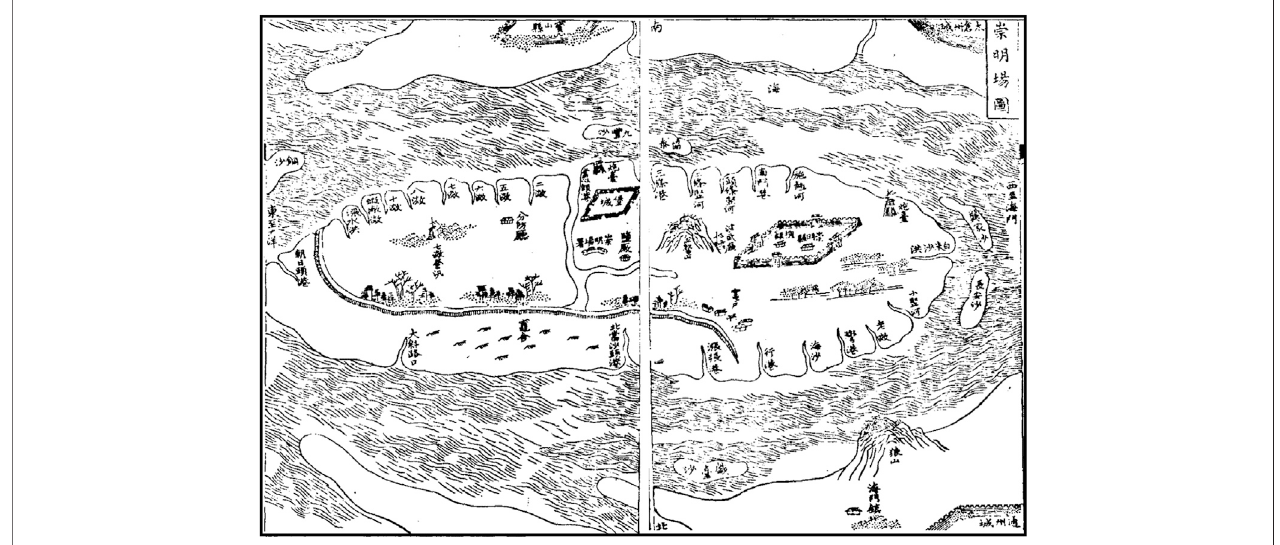
FIGURE3 | Historical map showing the settings ofChongmingSaltworks and the landscape ofthe Island. Note thatthis map isan overview picture ofChongming Island in the late 18th century, an original picture from Yan (1799), including information of saltworks, river, sea dike, county government setting, without latitude and longitude; north at the bottom and south at the top in this